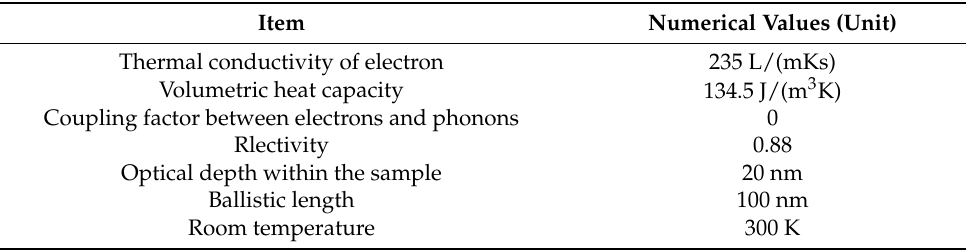
Table 1. Parameters used as input in the simulation model.